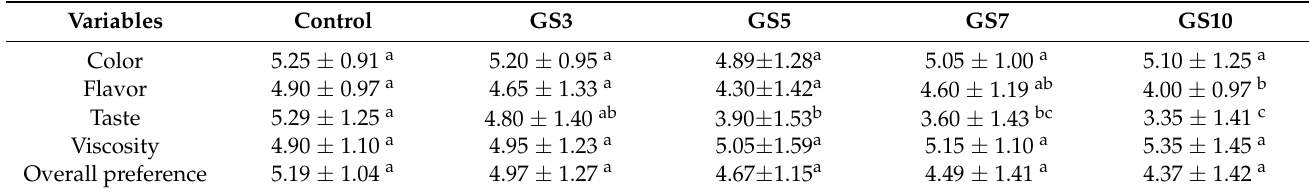
Table 3. Sensory evaluations of cream soup added with ginseng